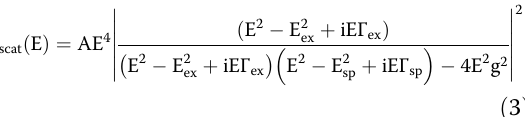
Table 1 Thickness of PE spacer with different layers (measured by Ellipsometry) Sample 1-PE